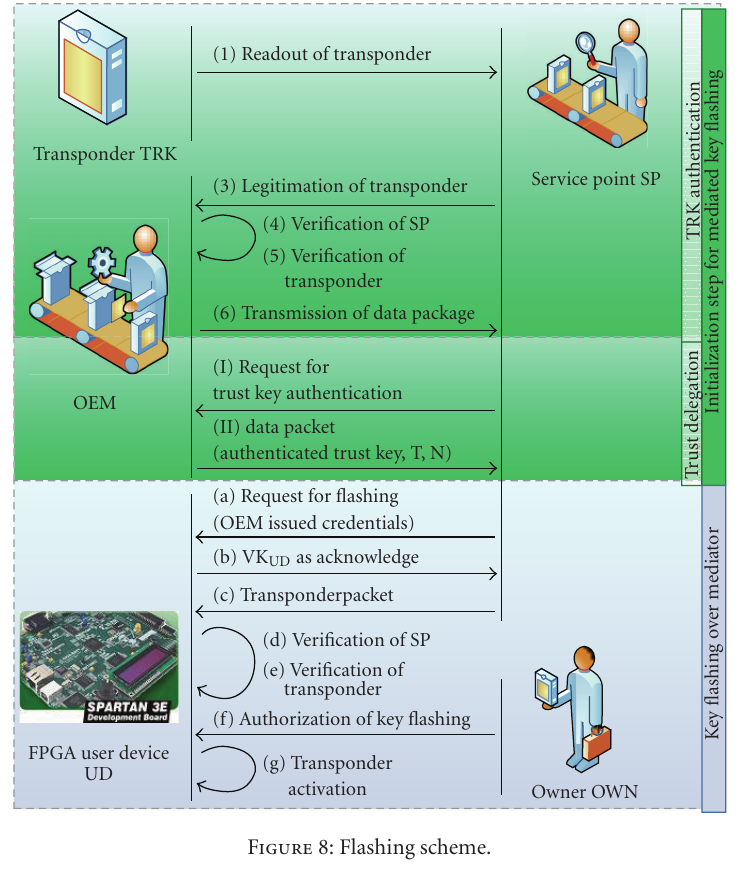
Figure 8: Flashing scheme.